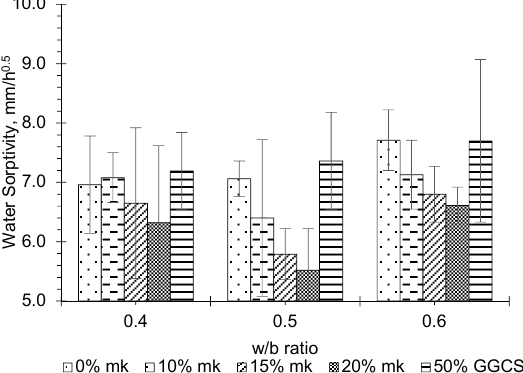
Figure 4. Water sorptivity index of concrete at different w/b